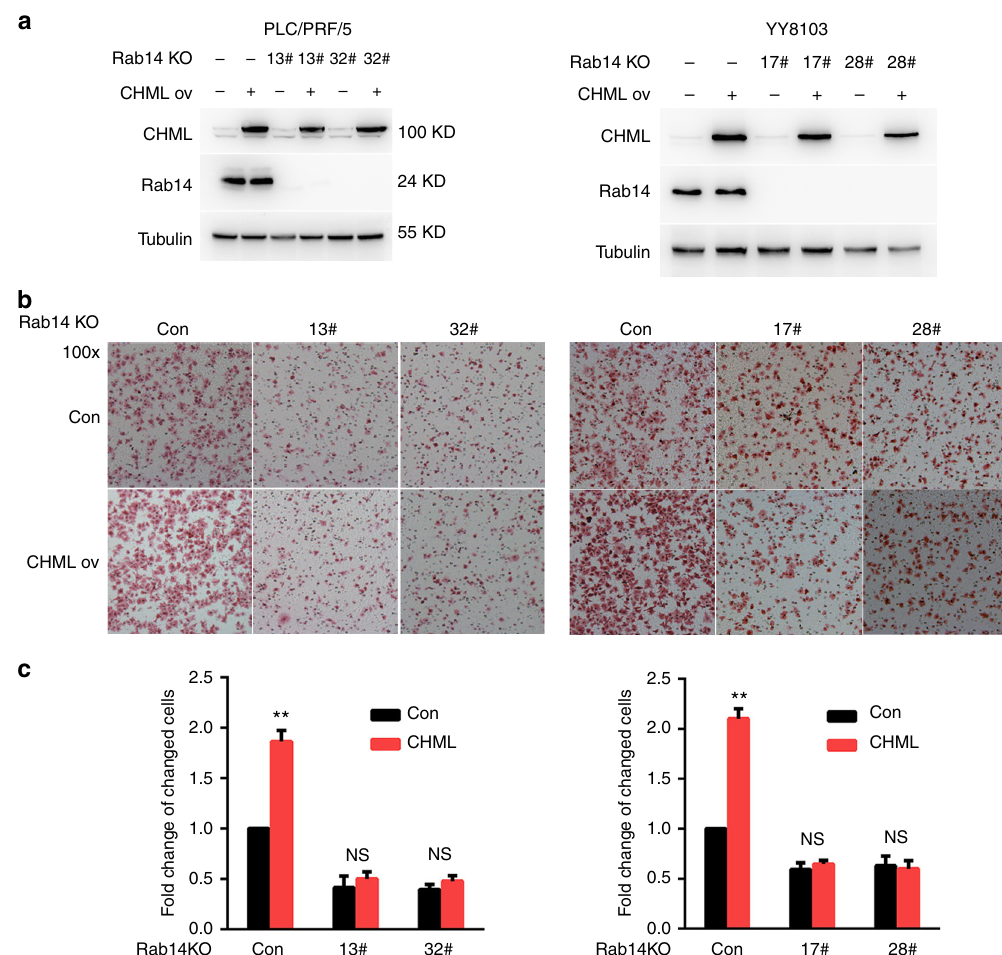
Fig. 5 Function of CHML is Rab14-dependent. a Western blot analysis of the knockout ef fi ciency of Rab14 and overexpression ef fi ciency of CHML in HCC cell line PLC/PRF/5 and YY8103. b Boyden chamber assay was performed to detect the metastatic ability of these indicated cells. Representative images are shown. c Quantitative results are respectively illustrated for panel ( b ). NS not signi fi cant. Data are shown as the mean ± s.e.m., ** P < 0.01 by two-tailed unpaired Student ’ s t -test. All data are represented as mean ±